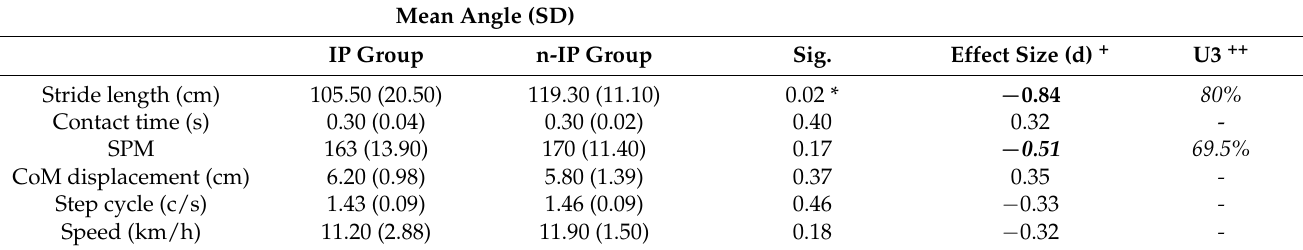
Table 2. Spatiotemporal parameters of recreational runners.